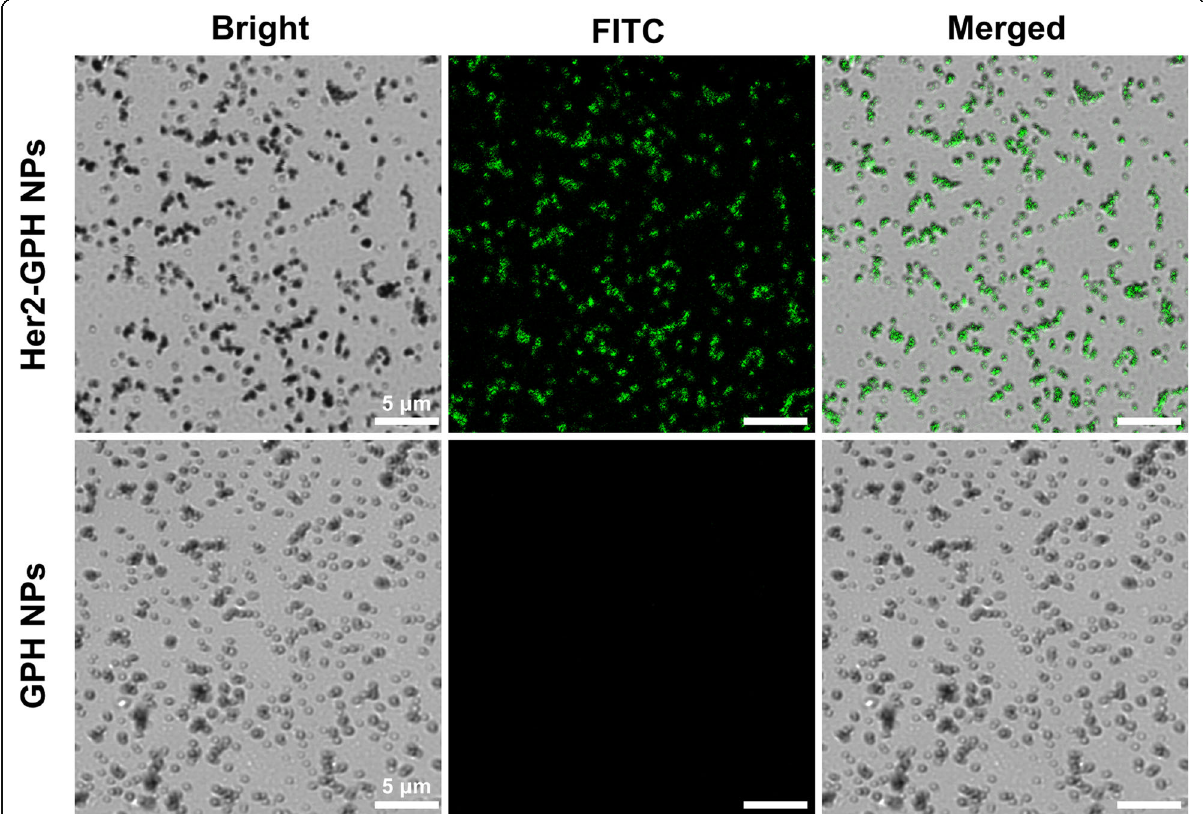
Fig. 6 Confocal microscopic images of Her2-GPH NPs and GPH NPs in bright field, FITC fluorescence and merged channels (scale bar = 5 μ